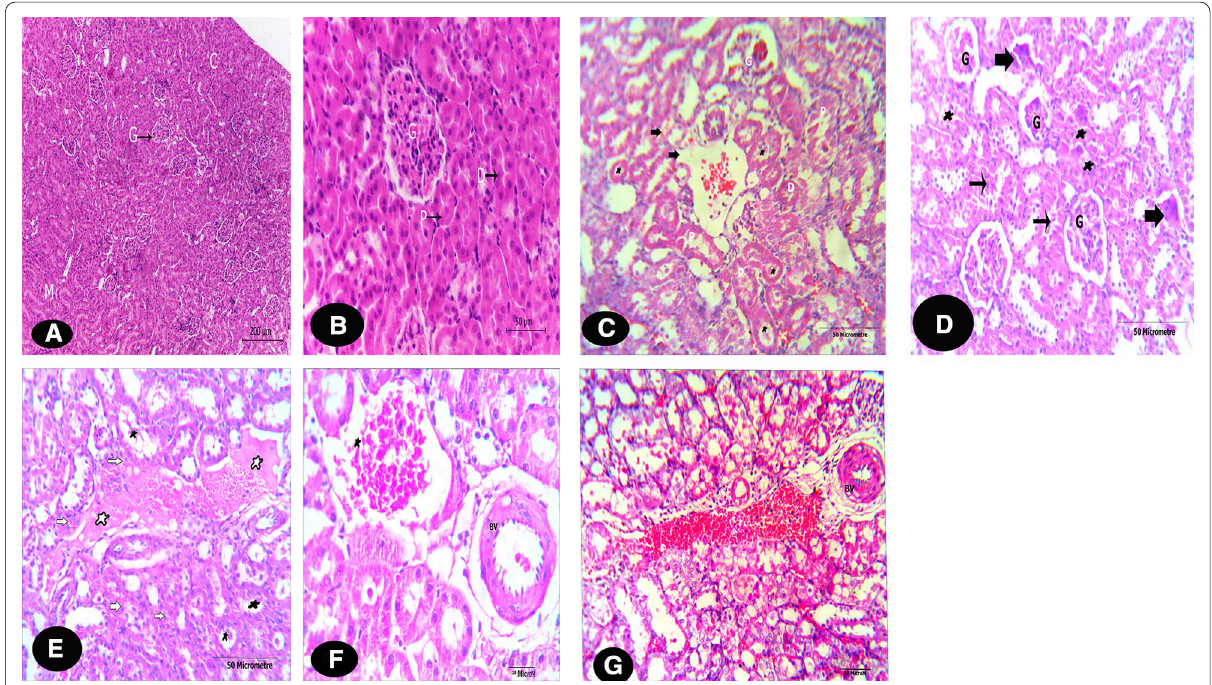
Fig. 5 A–G Photomicrographs of T. S. of kidneys of rats of G1 showing part of the cortices (C, H&E). A The cortex is characterized by the presence of numerous glomeruli (G). (X 100, H&E). B A magnified part of the cortex of A exhibit normal typical structure of G, proximal convoluted tubules (P) and distal convoluted tubules (D). (X 400, H&E) . C A photomicrograph of T. S. of kidney of G2 showing proximal (P) & distal (D) tubular necrosis with variable degrees of stainability. The necrotic cells fell into the tubules’ lumen and obliterated them (*). Notice the vacuolar changes (arrows), the G degeneration and capsular thickening. (X 100, G2, H&E). D A photomicrograph of T. S. of kidney of G3 showing moderate alterations restricted to few spots per each examined section, and hypercellularity (*). The glomerular alterations include clefted and shrunken glomeruli (G and arrow, respectively). (X 100, G3, H&E). E A photomicrographs of T. S. of kidneys of G4 showing sever degradation of the kidney tubules (white‑arrows). In most cases, the tubules show obliterated lumina (black asterisk), and hypercellularity in between. The interstitial areas among the renal tubules together with the lumina of the renal tubules were congested with blood cells (white asterisk). Notice the cellular infiltration (thin black arrow). (X 100, G4 ). F & G showing degenerated, widened, and thickened BVs, plus severe vacuolar degeneration. Notice variable degrees of necrotic changes in both sections. The interstitial areas among the renal tubules together with the lumina of the renal tubules were congested with blood cells. (X 400 and 100; respectively, G4